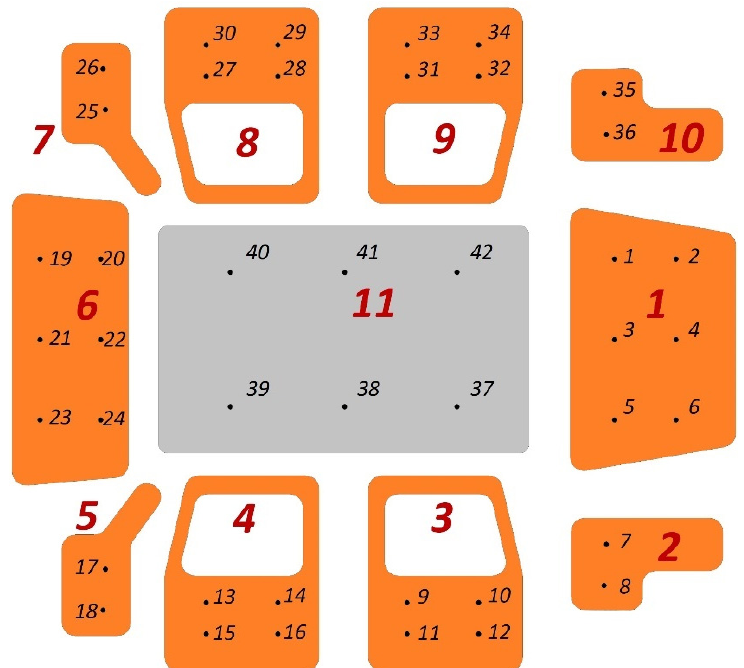
Figure 3. Measurement point distribution on a car body; the number of elements was marked by red color. red